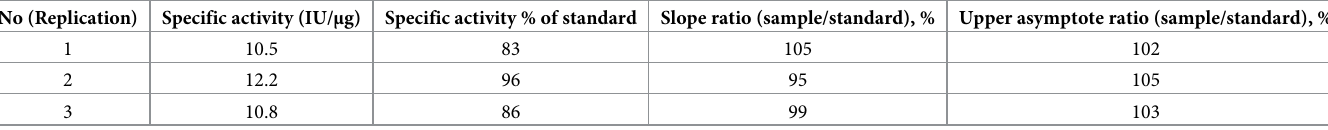
Table 2. Association and dissociation constants for the interaction of purified FSH with FSH receptor. Sample k on , nM -1 � min -1 k off , min -1 t 1/2 , min Gonal-F 0.89 ± 0.23 0.0057 ± 0.0017 FSH #1 0.71 ± 0.13 0.0034 ± 0.0006 209 ± 35 4.8 ± 1.2 FSH #2 0.65 ± 0.16 0.0043 ± 0.0008 167 ± 31 6.6 ± 2.1 Data are given as mean ± 95% confidence interval, n = 2.